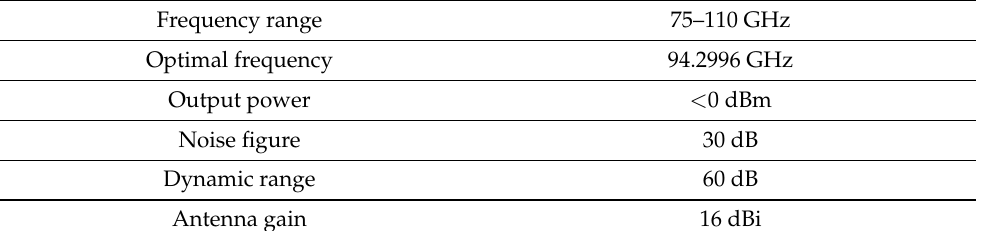
Table 3. Parameters of the radar system.